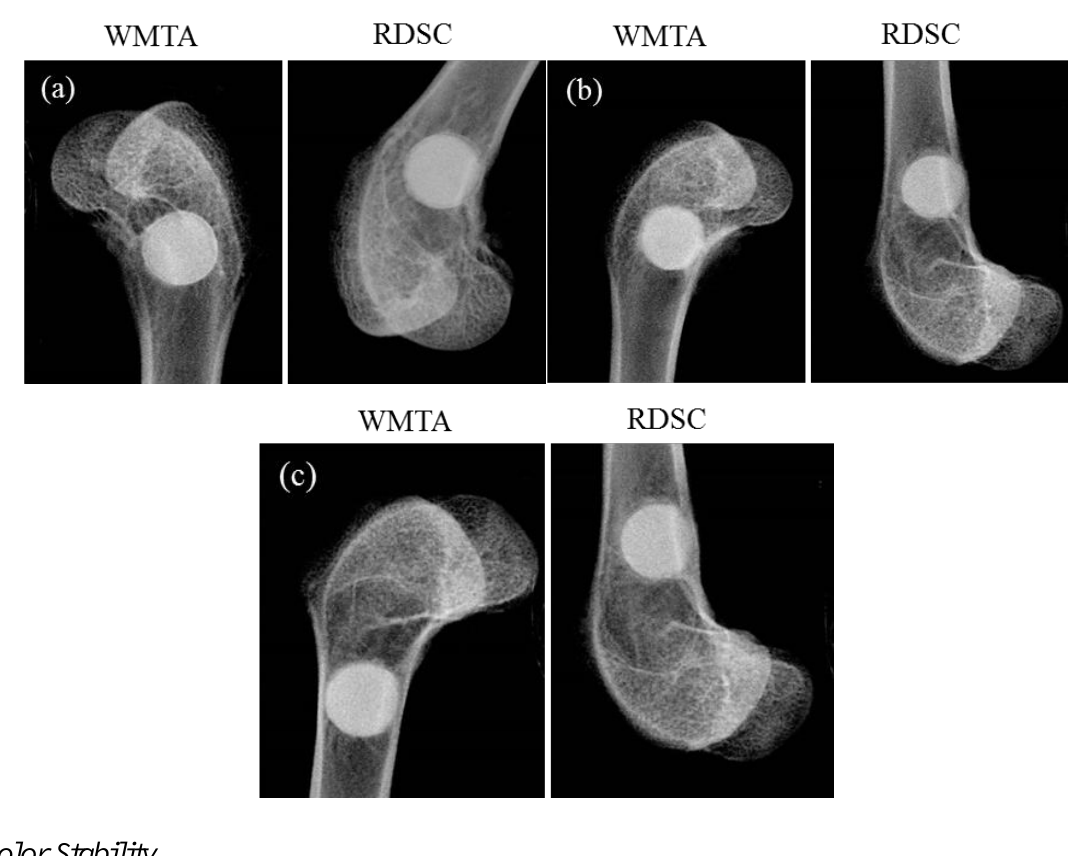
Figure 1. Radiographs of cements implanted in the defect of the distal medial femur for ( a ) 1; ( b ) 3; and ( c ) 6 months using a Minray dental X-ray unit (Soredex, Tuusula, Finland) operated at 60 kV and 7 mA with an exposure time of 0.1 sec. (white-colored mineral trioxide aggregate (WMTA); radiopaque dicalcium silicate cement